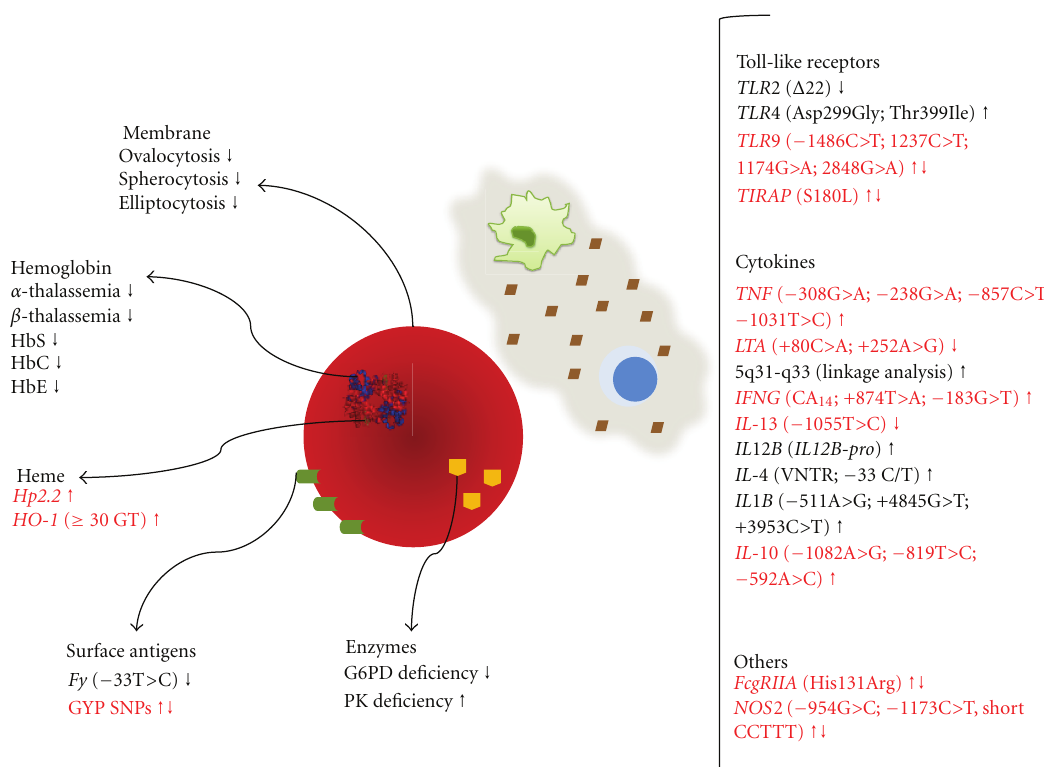
Figure 1: Influence of erythrocyte and immune response gene polymorphisms in malaria outcome. The diagram summarizes the major genetic alterations identified in the erythrocyte and immune response pathways that influence malaria outcome. The up arrow indicates susceptibility, and the down arrow indicates resistance to malaria. Contradictory or not confirmed results are represented by red font color. The protective e ff ect of inherited genetic disorders involving the RBC on malaria infection has been associated with membrane cytoskeleton disorders, surface antigen mutations, enzymatic machinery deficiencies, or hemoglobin and its heme prosthetic group alterations. Considering the immune response, several polymorphisms in gene encoding the TLR receptors and in important cytokines involved in malaria immunopathology are described in the literature. Furthermore, genetic alterations in the FcgRIIA receptor and nitric oxide synthase were also associated with resistance/susceptibility to